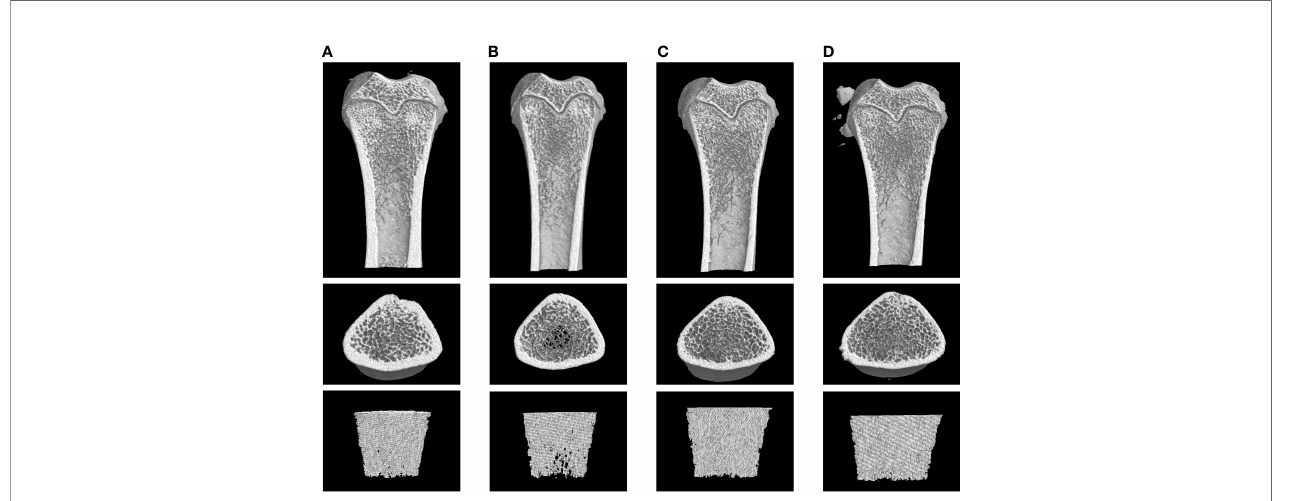
FIGURE 9 | Representative 3D reconstructions of micro-CT analysis of the femur from Blank (A) , GIOP (B) , Positive (C) and TFDR (D) group (n = 6).